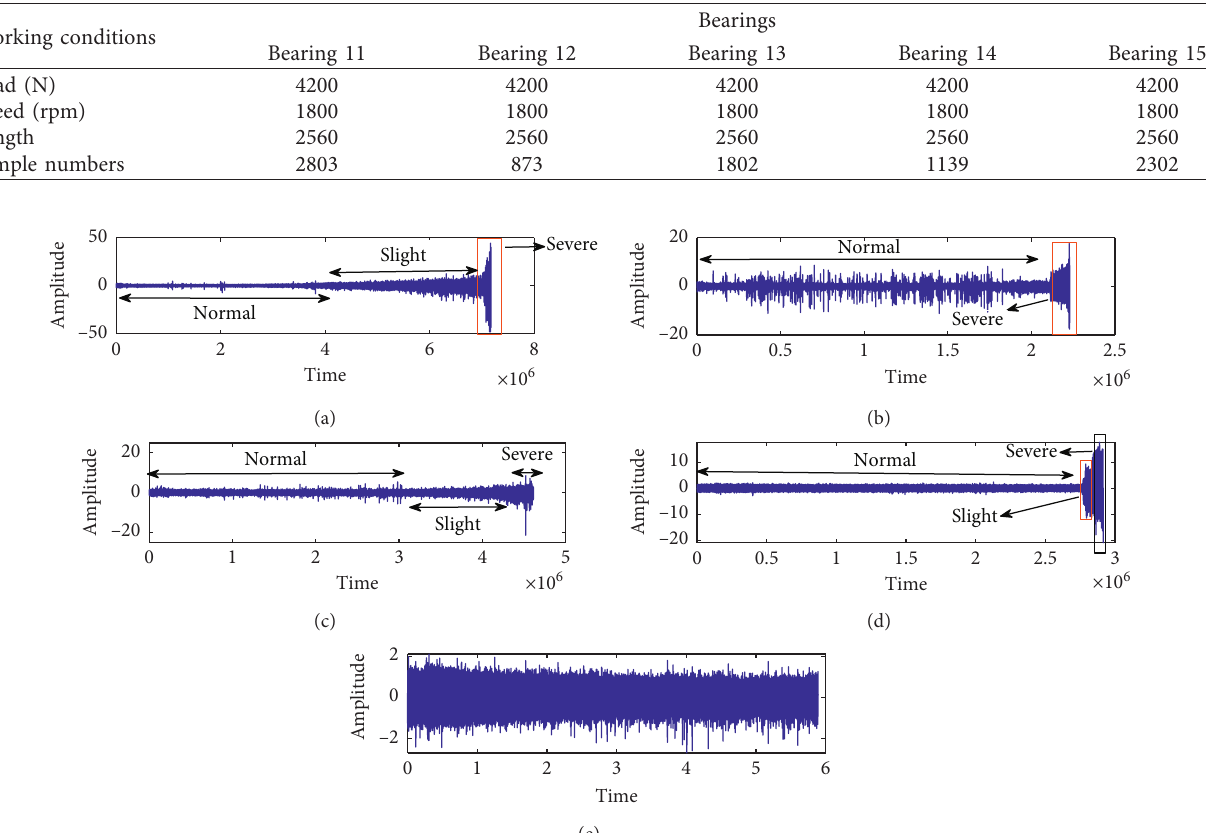
Figure 6: Time-wave figure of the original vibration for bearings 11–15. (a) Bearing 11. (b) Bearing 12. (c) Bearing 13. (d) Bearing 14. (e) Bearing 15.